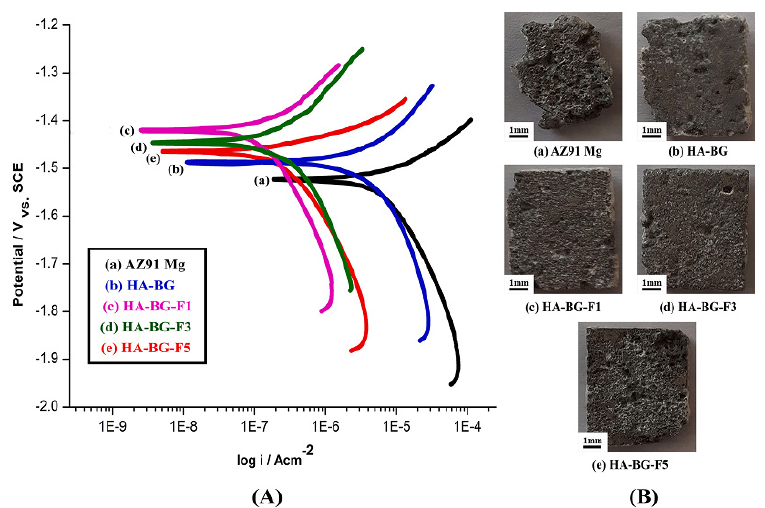
Figure 10. ( A ) Potentiodynamic polarization curves and ( B ) Optical images after the corrosion test for uncoated and HA–BG–Fe 3 O 4 coating. Reprinted with permission from [110]; Copyright 2021 Elsevier.